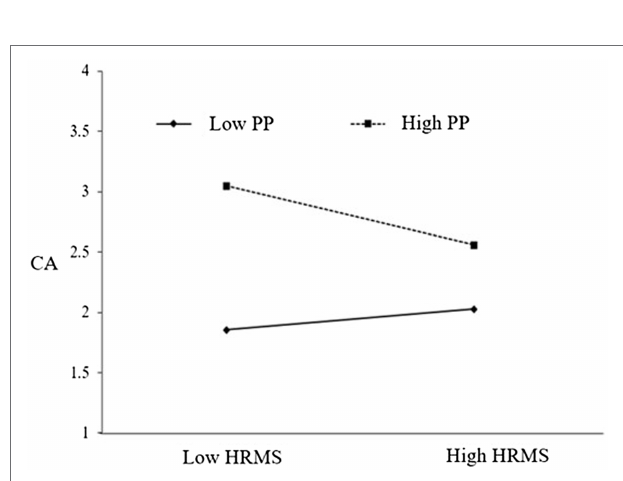
FIGURE 3 | The moderating role of proactive personality in the influence of HRMS on CA.